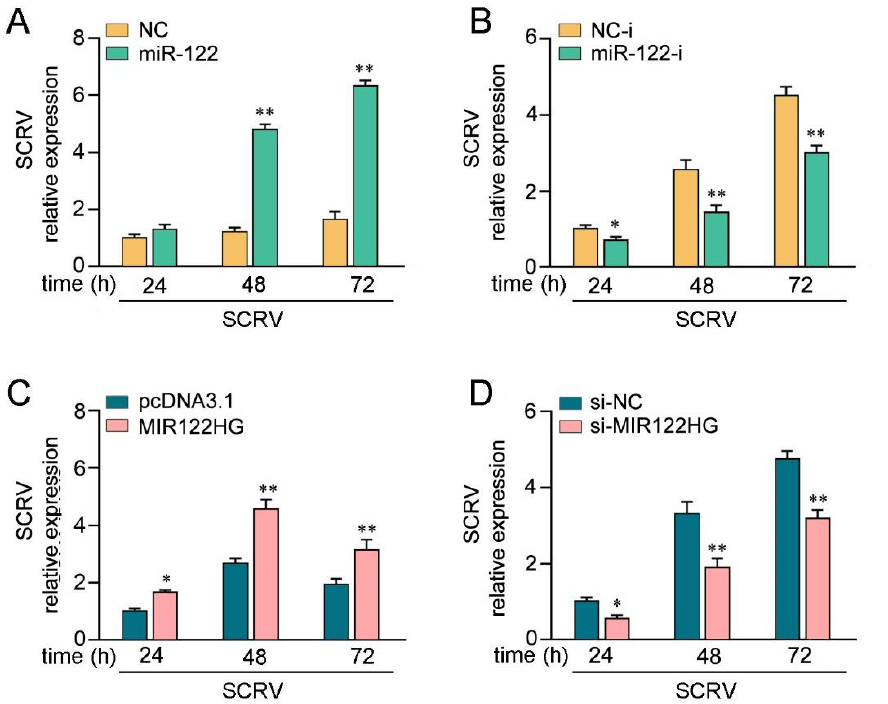
Figure 5. LncRNA MIR122HG promotes SCRV replication. ( A , B ) MKCs were transfected with miR-122 or NC ( A ), miR-122-i or NC-i ( B ) for 24 h and then treated withSCRV at different times.The SCRV level in the intracellular was measured by qPCR. ( C , D ) MKCs were transfected with MIR122HG or pcDNA3.1 ( C ), si-MIR122HG, or si-NC ( D ) for 24 h and then SCRV treated at adifferent time. The SCRV level in the intracellular was determined by qPCR. All data are presented as the means ± SE from at least three independent triplicate experiments. **, p < 0.01; *, p < 0.05 for the controls.